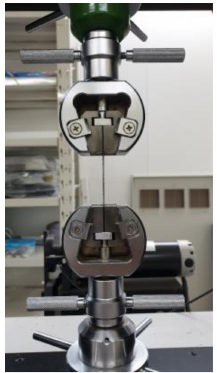
Figure 5. Monotonic tensile test